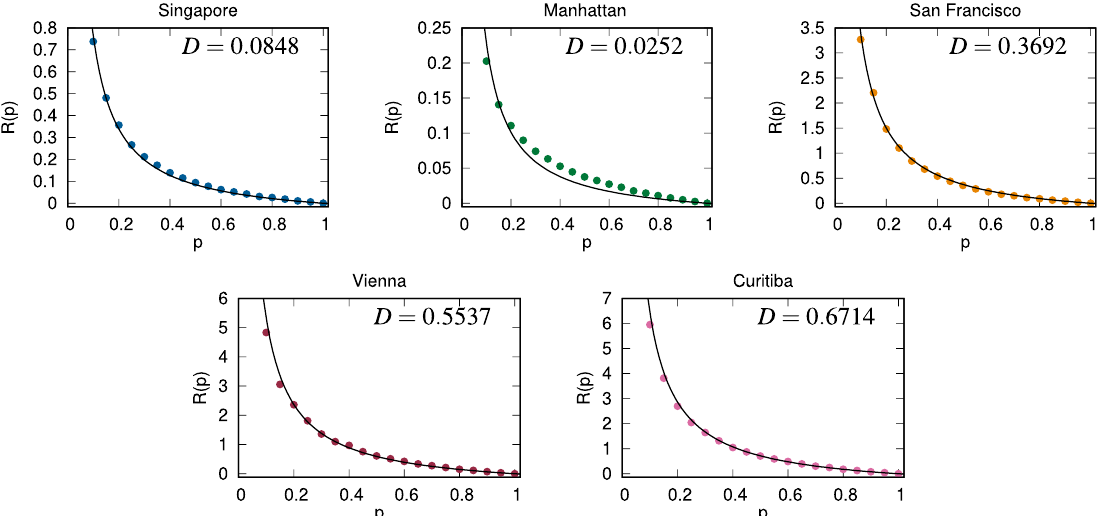
Figure 1. Fleet size factors for five cities determined via simulations as a function of demand segmentation, i.e. the share of trips an operator is serving. The lines are best fit curves of the relationship R ( p ) = D ( 1 / p − 1 ) ; fitted values of D are shown in the individual